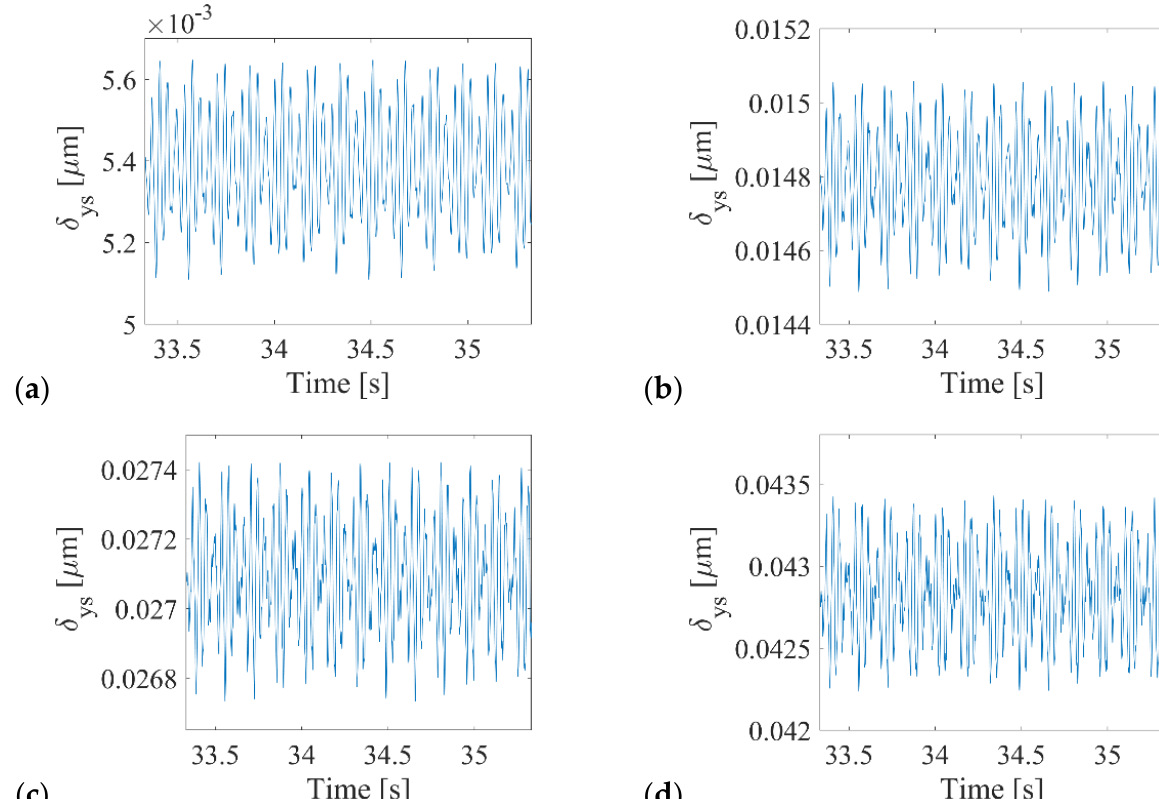
Figure 5. Vertical Deformations δ ys time series for radial internal clearance ( a ) RIC = 5.5 μm, ( b ) RIC = 16 μm, ( c ) RIC = 30 μm, ( d ) RIC = 48 μm.